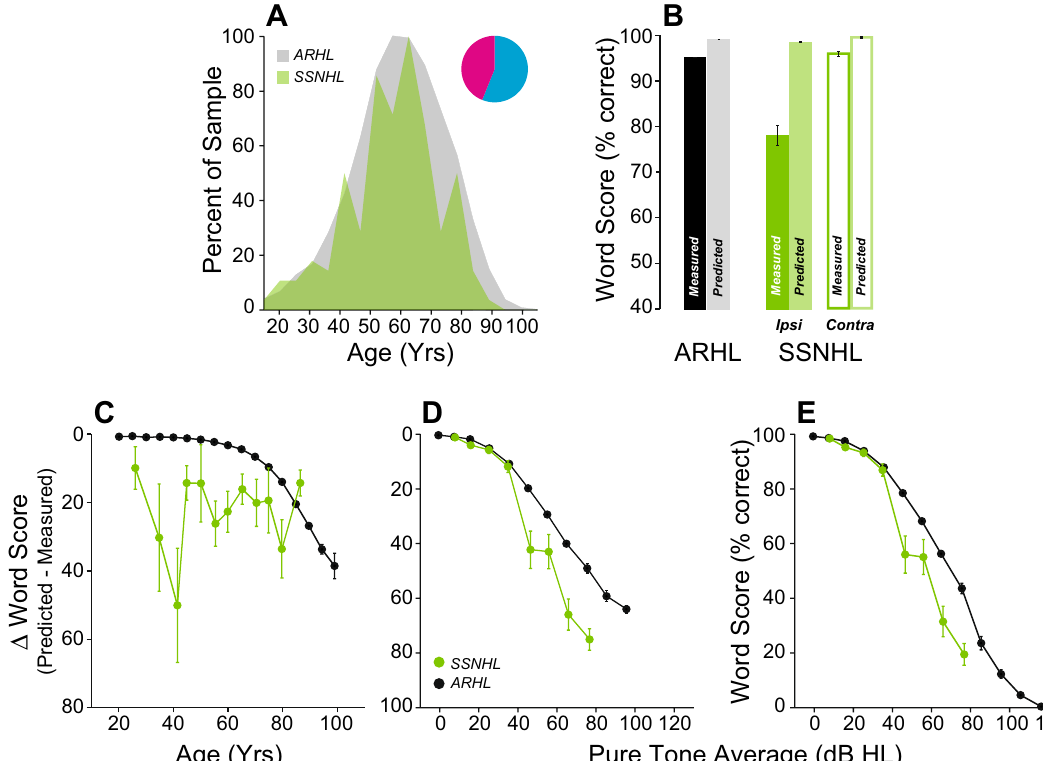
Figure 11. Intelligibility deficits in patients with Sudden Sensorineural Hearing Loss (SSNHL) are significantly worse than age-matched controls. ( A ) Age distribution of patients with SSNHL. Pie chart indicates the proportion of male (cyan) vs. female (magenta). ( B ) Comparison of mean WRS as measured in patients with SSNHL or predicted by the speech intelligibility curve. Scores are compared across ears (ipsi vs. contra) and with patients presenting ARHL. ( C – E ) Speech Intelligibility deficits as a function of age ( C ) or pure-tone average ( D , E ). Legend in ( D ) applies to ( C , E